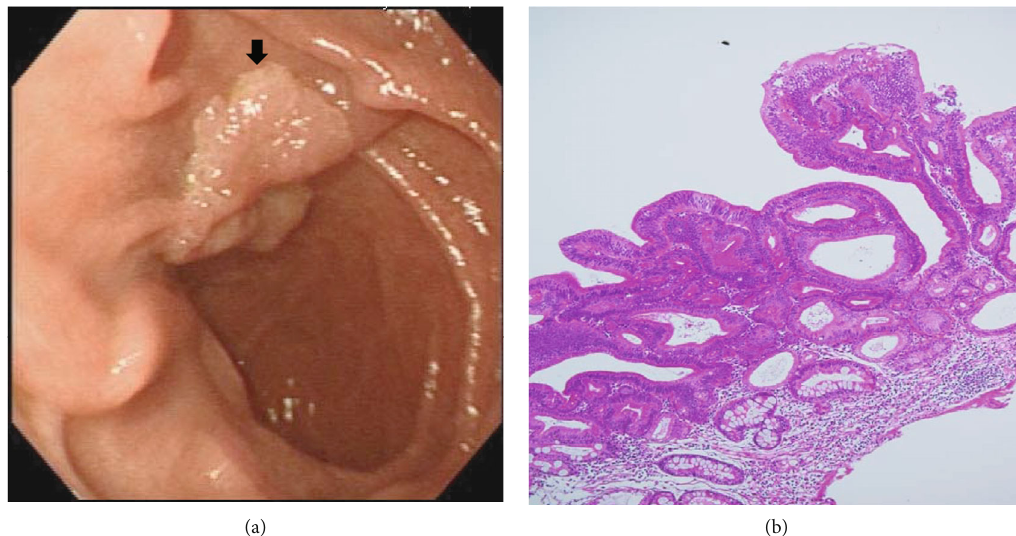
Figure 4: (a) Flat polyp over the infrapapillary area (arrow). (b) Duodenal villous adenoma with moderate dysplasia composed of dysplastic glandular cells with low-grade dysplasia in villous architecture (H&E, 100x).